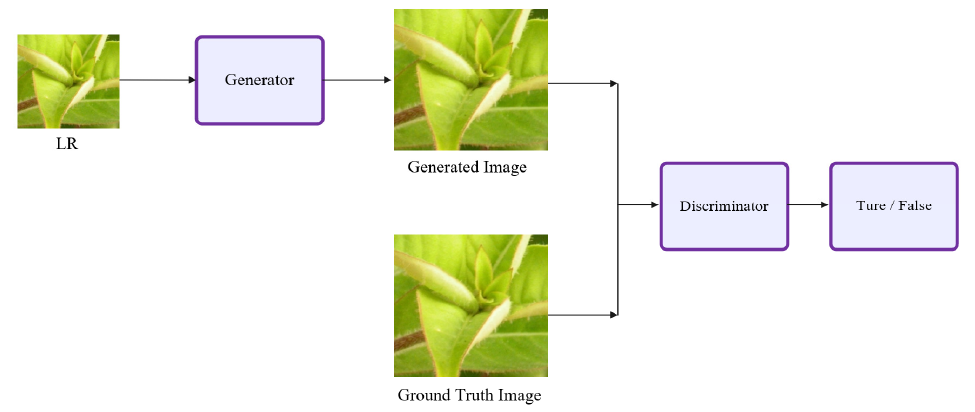
Figure 1. The frame diagram of SRGAN.